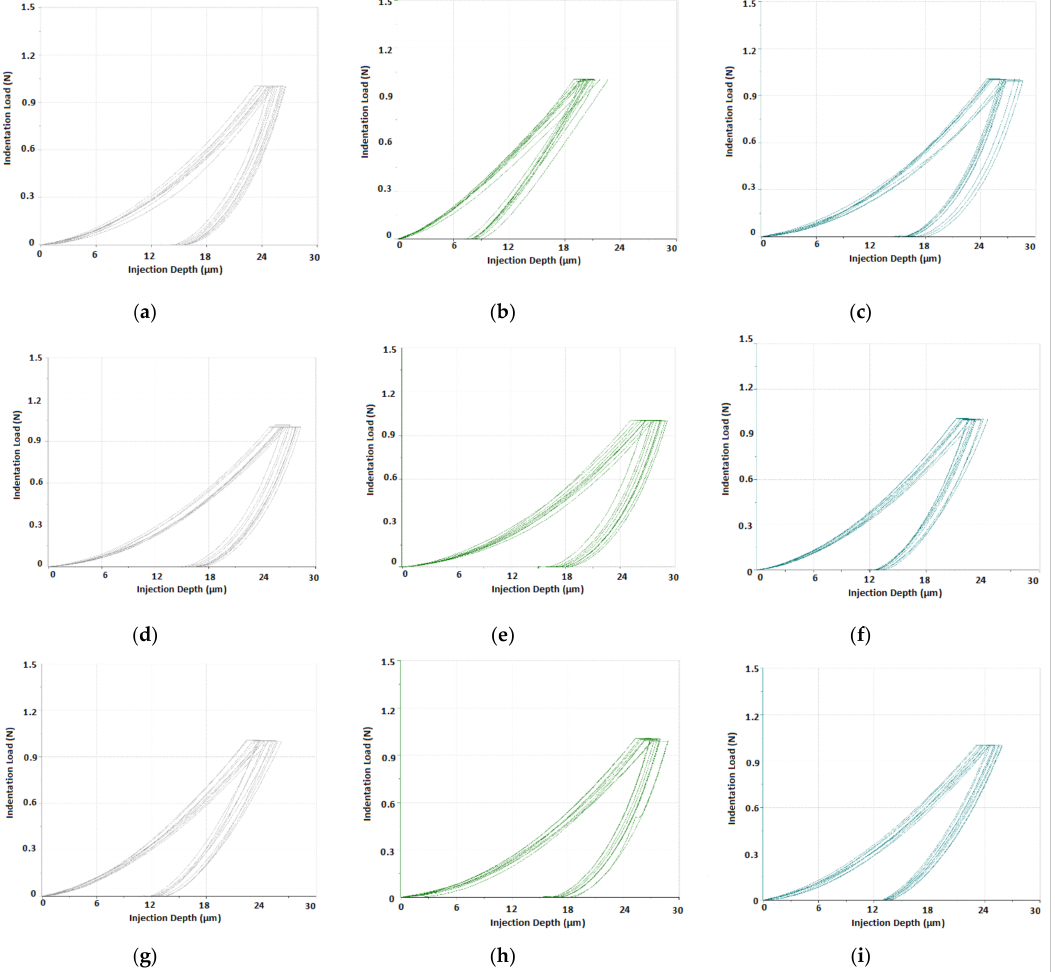
Figure 5. The indentation P-h curves at surface quality with different flow length: ( a ) Ra 0.1, 0 mm; ( b ) Ra 0.1, 53 mm; ( c ) Ra 0.1, 70 mm; ( d ) Ra 0.8, 0 mm; ( e ) Ra 0.8, 53 mm; ( f ) Ra 0.8, 70 mm; ( g ) Ra 1.6, 0 mm; ( h ) Ra 1.6, 53 mm; ( i ) Ra 1.6, 70